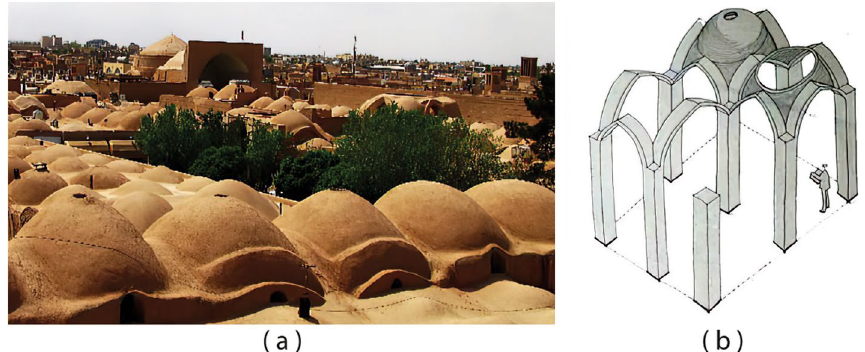
Fig. 16 Kolombo vaults in Yazd adobe architecture: ( a ) the rooftop of the bazaar of Khan Square of Yazd and ( b ) construction technique of the vault (Source: ICHHTO 2016)